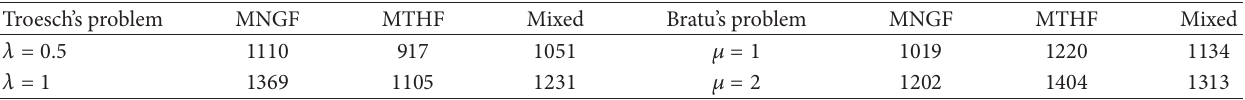
Table 10: The convergence speed of the algorithm using different initialization functions for Troesch’s and Bratu’s problems. Troesch’s problem MNGF MTHF Mixed Bratu’s problem MNGF MTHF Mixed